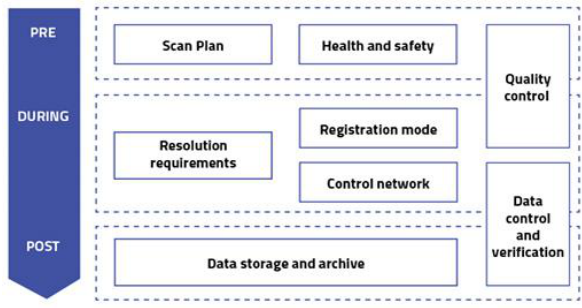
Figure 3. Workflow steps and activity indicators